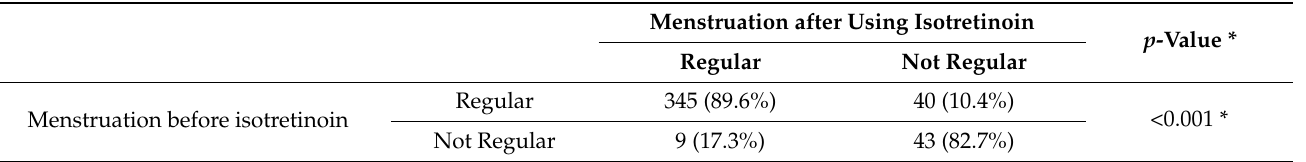
Table 3. Menstrual cycle and mensuration characteristics before and after